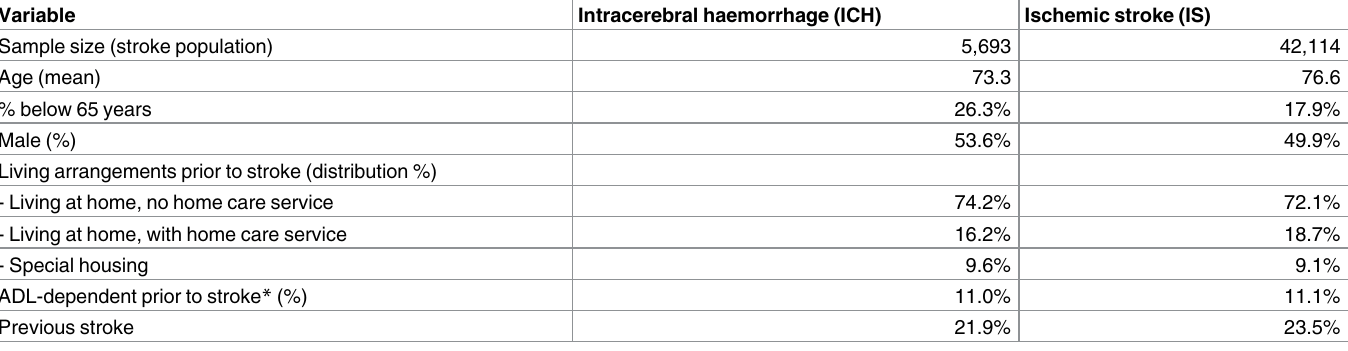
Table 2. Descriptivestatistics of study sample.